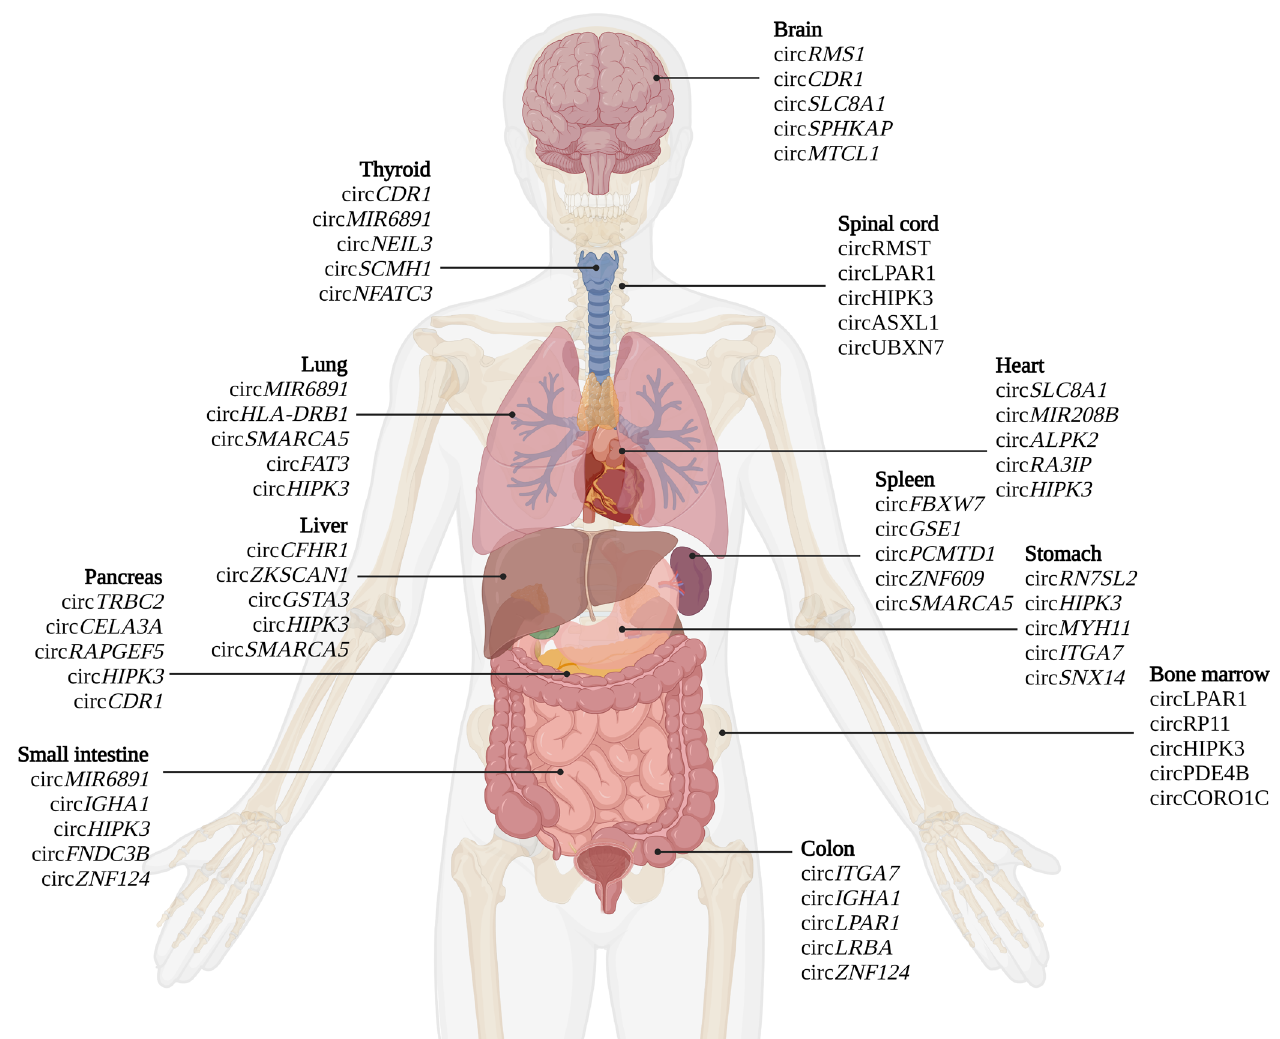
Figure 2. The top 5 circRNAs with the highest expression in a particular organ, according to the circAtlas database.